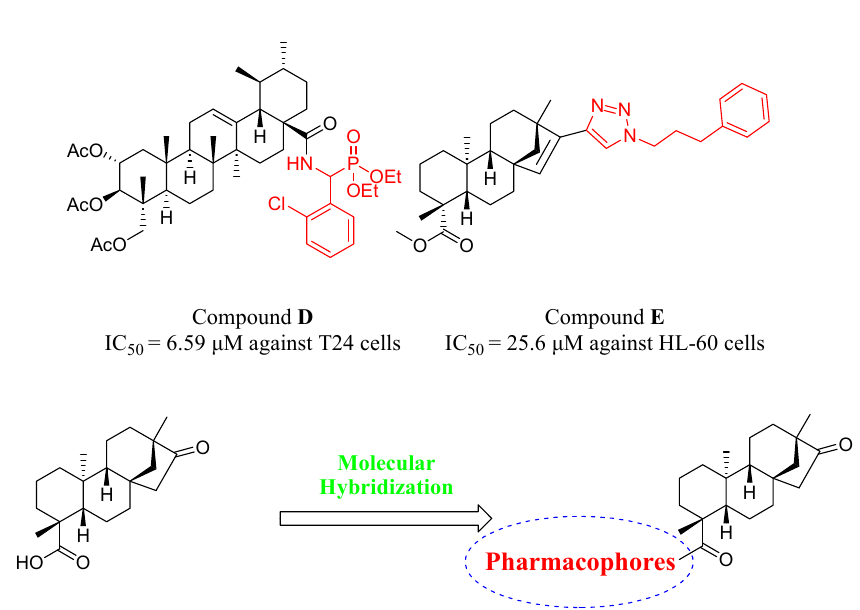
Figure 2. Design of target compounds based on the combination principles (The black part represents the parent compound and the red part represents the pharmacophore).